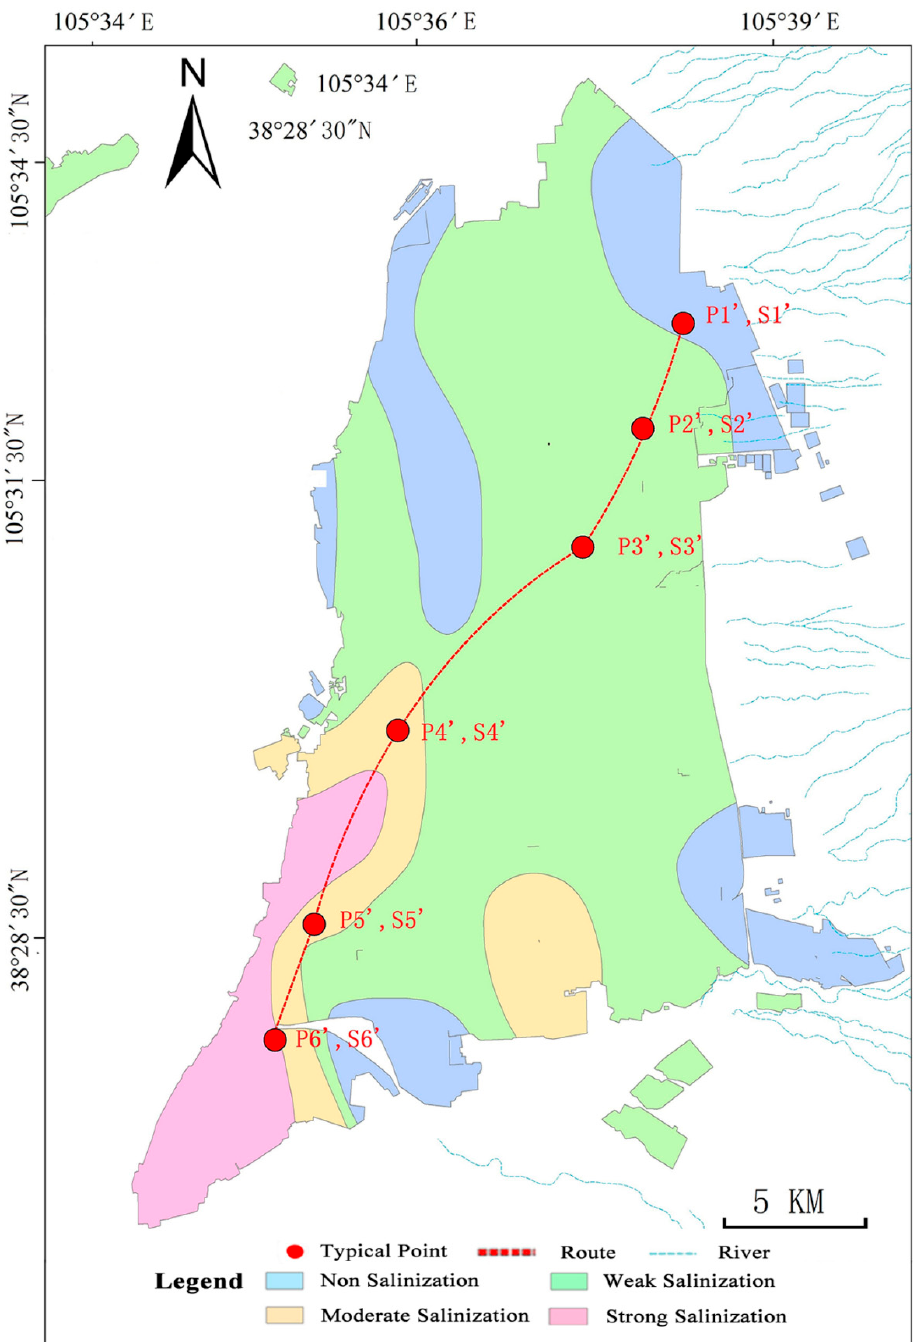
Figure 9. Soil salinity degree of the study area.